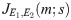
Predictability of a node’s epidemic risk.For each of 5000 selections of a random single seed, two simulations on the encounter network, one on the static network and one on the friendship network are run independently. The average similarities J⋅,⋅(m; s) of the infected sets over all seed selections are shown for different pairs of simulations and different target infection size m (x-axis). First panel: JE1,E2(m;s) (two independent infections on the encounter network). Second panel: JE1, S(m; s) (one infection on the encounter network, one infection on the static encounter network). Third panel: JE1, F(m; s) (one infection on the encounter network, one infection on the friendship network). Fourth panel: Jaccard similarity between infections on the encounter network and random infected sets of size m (nodes belonging to the encounter network). Black points represent the averages of the metrics over all observations such that the metrics are defined, and bars represent standard deviations. Higher values of the y-axis correspond to higher prediction accuracy.